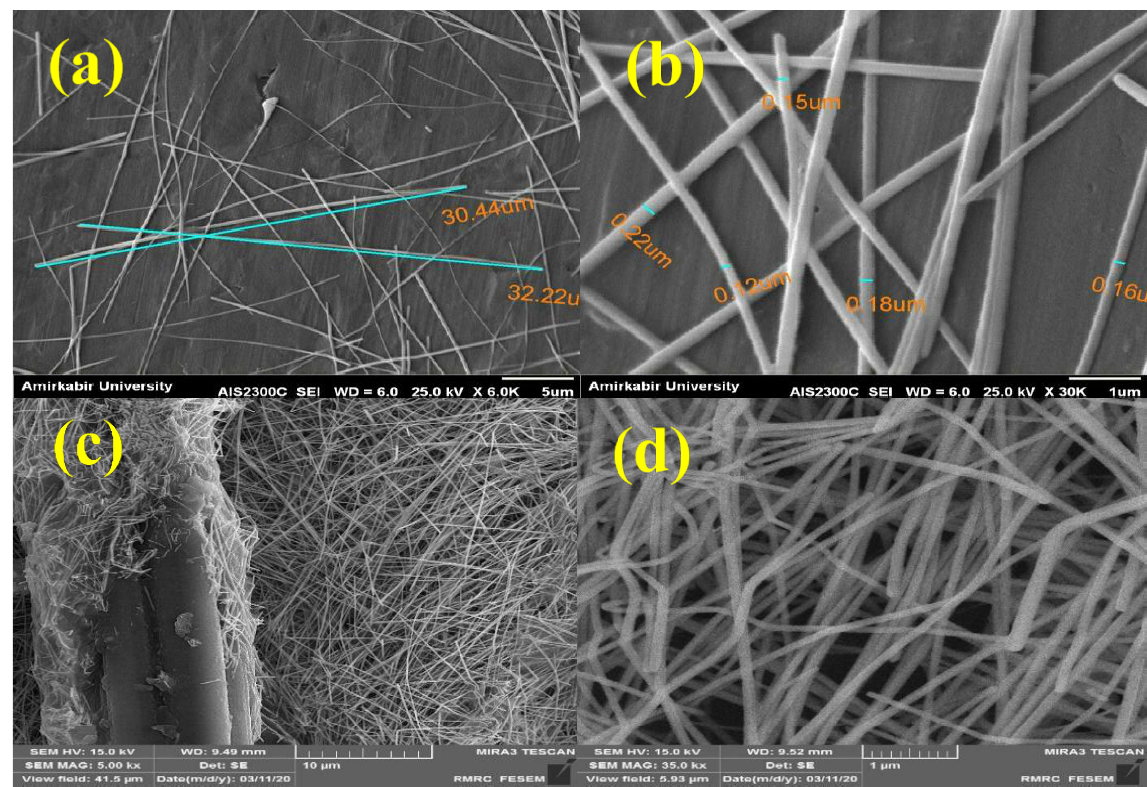
Figure 2. SEM images of the silver nanowires in different magnifications ( a , b ), SEM images of cotton fabric coated with silver nanowires ( c , d ).